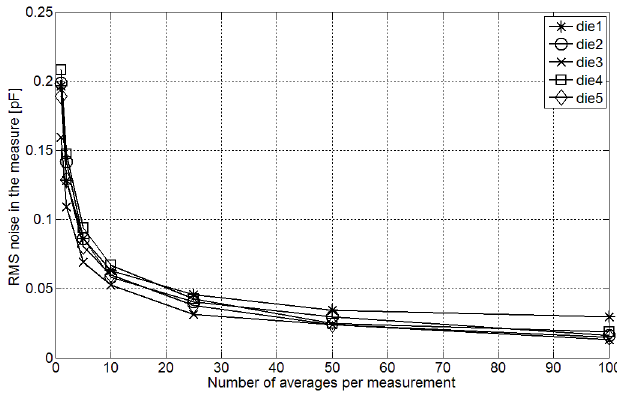
Figure 9. RMS noise in the measurements when converting a 10 pF C